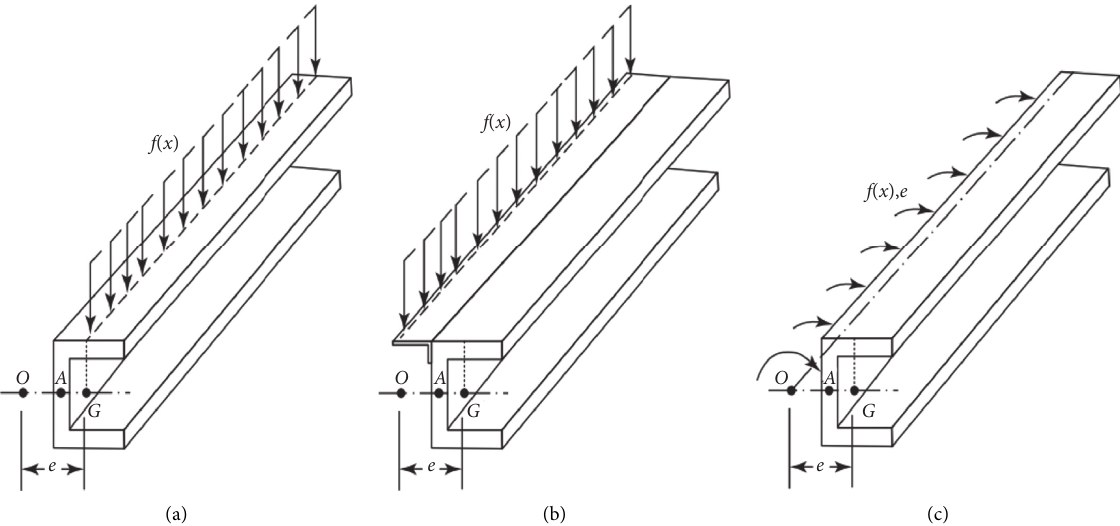
Figure 4: Types of bearing capacity of shaft, (a) central axial force, (b) axial force at slip center, and (c) moment at slip center.